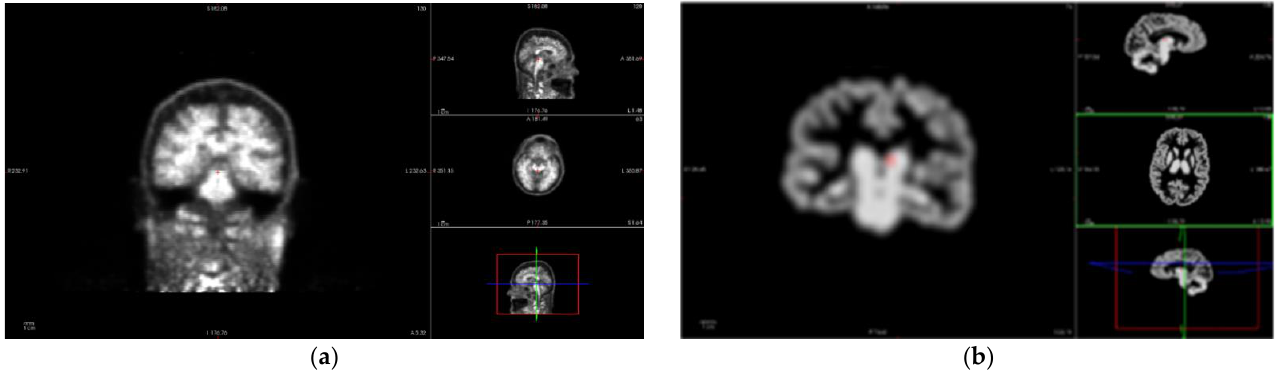
Figure 4. PET images of the same patient as Figure 3. ( a ) PET image before applying Partial Volume Correction (PVC). In axial, sagittal, and coronal planes and 3D reconstruction, clockwise. ( b ) Result of applying Partial Volume Correction with Two-Components (PVC2C) to the PET study in ( a ), displaying the same planes in the same order.